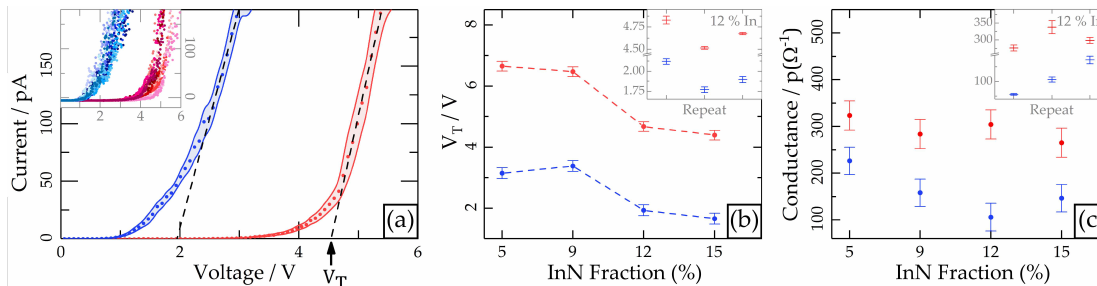
Figure 3. Current-voltage data obtained under illumination (blue) and no illumination (red) away from any defects. ( a ) Inset: raw data from In 0.12 Ga 0.88 N showing twenty I-V curves, ten with no illumination and ten with illumination. Main: average curves, which have been linearly fitted to extract a “turn-on” voltage ( V T , x-intercept) and conductance ( G , gradient); ( b ) V T for all InGaN thick films, where the error bars represent the standard deviation in repeated measurements over the course of the session. Inset: repeatedly measured V T for the In 0.12 Ga 0.88 N film, with error bars representing the